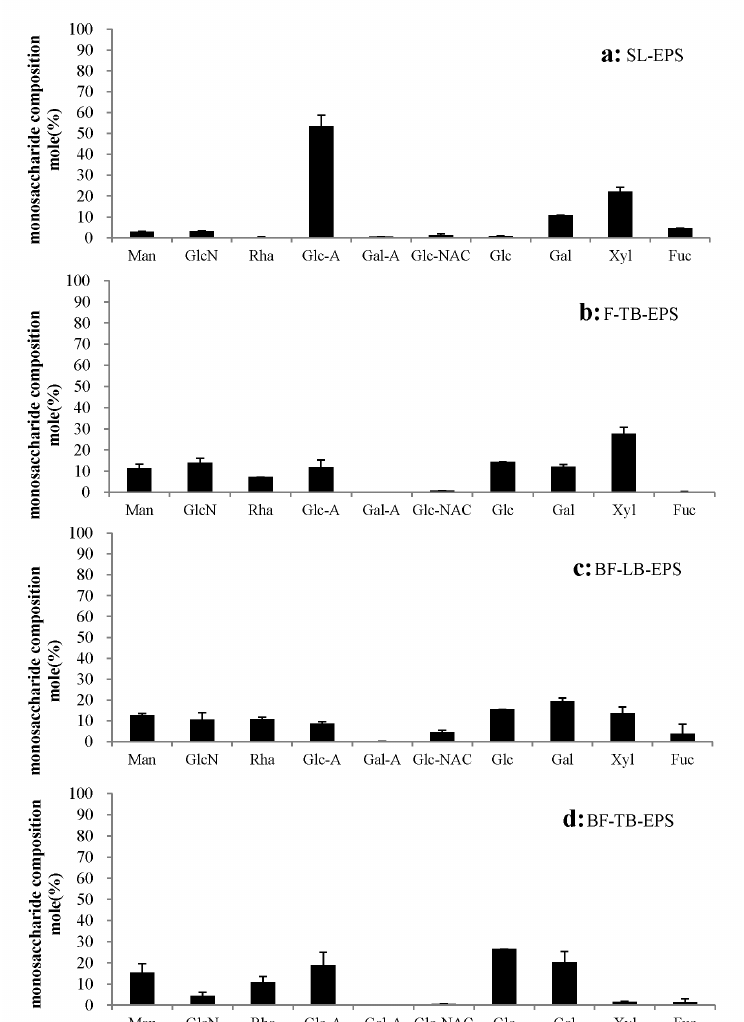
Figure 2 - The monosaccharides compositions in terms of mole percentages for EPS fractions from Amphora sp. The mole percentages were calculated based on the HPLC peak areas of at least 3 replicated samples, and the means and standard deviations are shown closed columns and bars, respectively. The unknown monosaccharides were ignored in the mole percentage calculations. a , b , c , and d represent the samples of SL-EPS, F-TB-EPS, BF-LB-EPS and BF-TB-EPS,